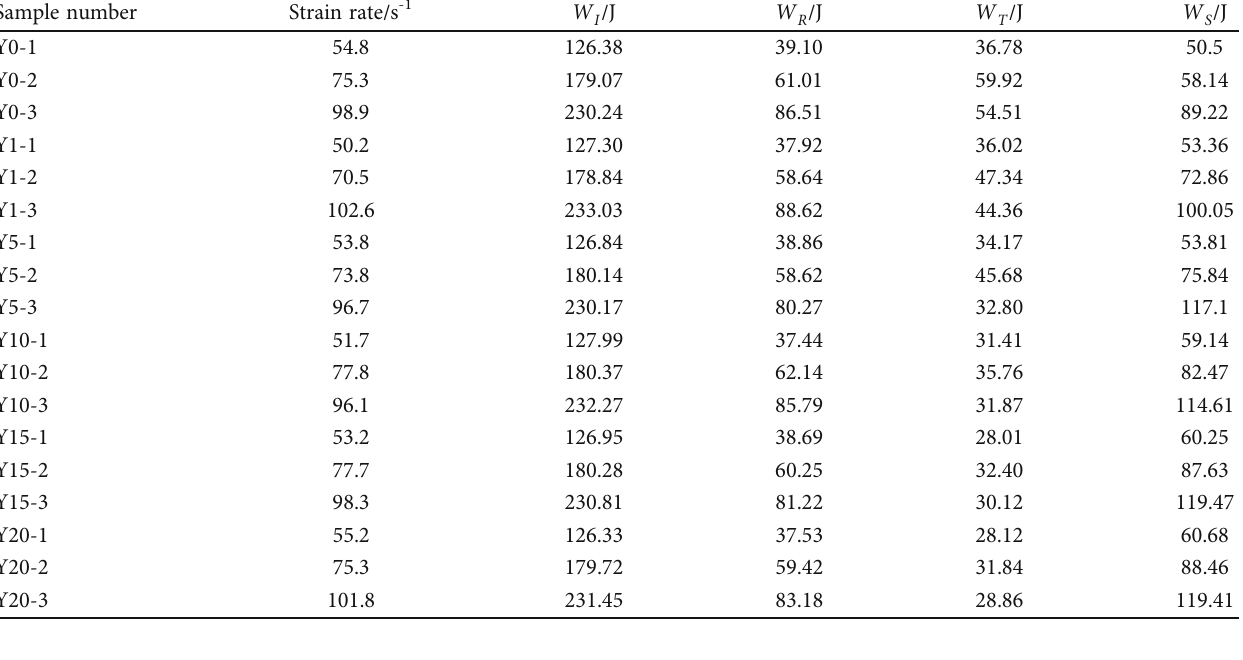
Table 4: Energy statistical table.